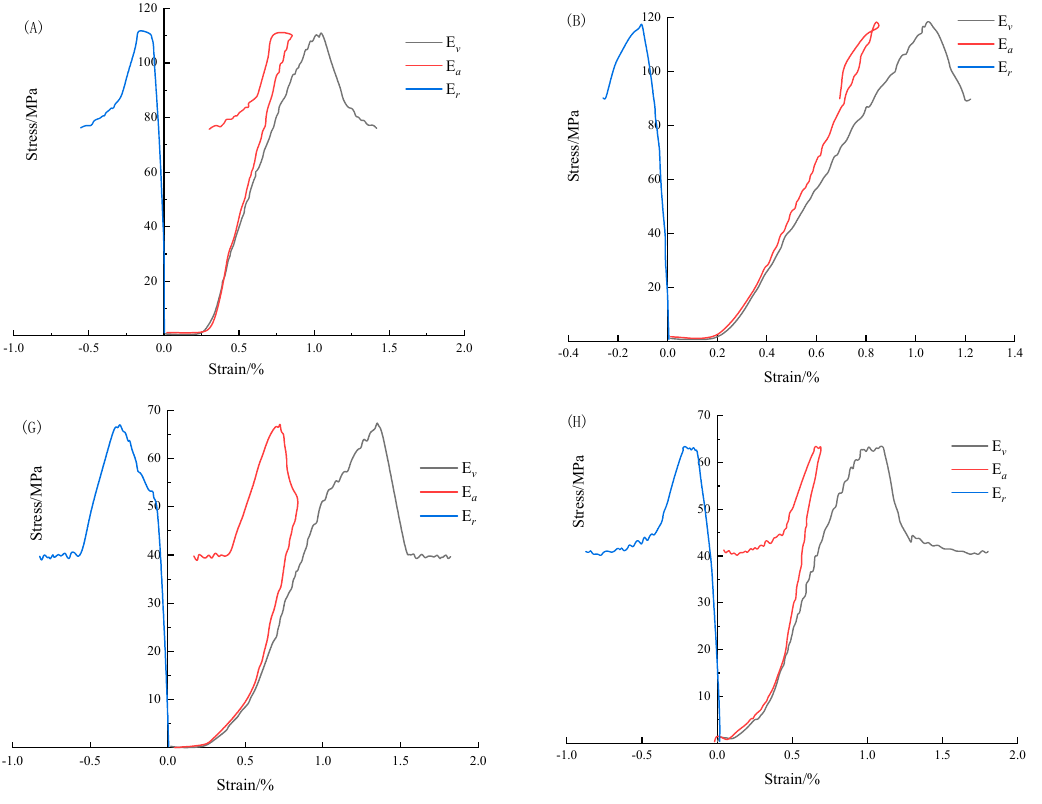
Figure 2. Triaxial mechanical experiment test curve.